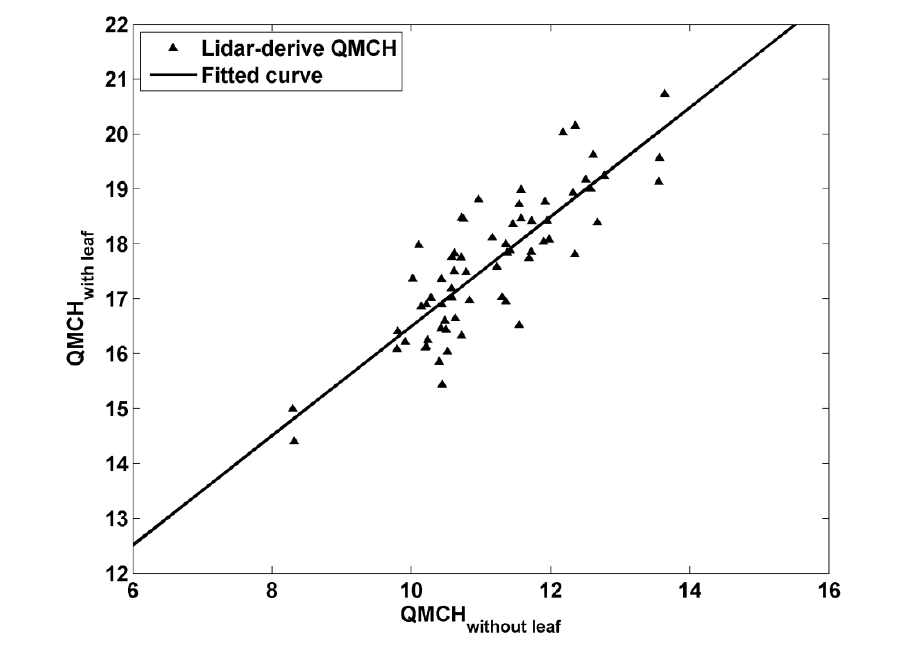
Figure 11. Comparison among the plot-level QMCHs (for 40 m × 40 m forest plots in Site 2), which are derived from experiments at Site 2 in summer 2012 (with leaf) and winter 2013 (without leaf). The relationship is found to be QMCH QMCH + 6.5 ( r 2 without leaf